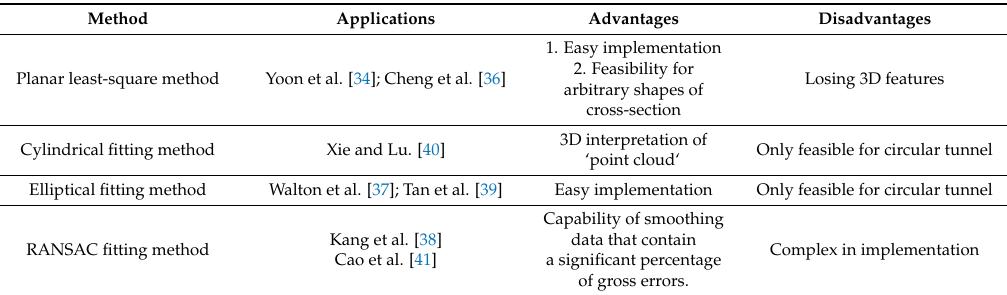
Table 1. Summary of algorithms used for cross-section fitting.